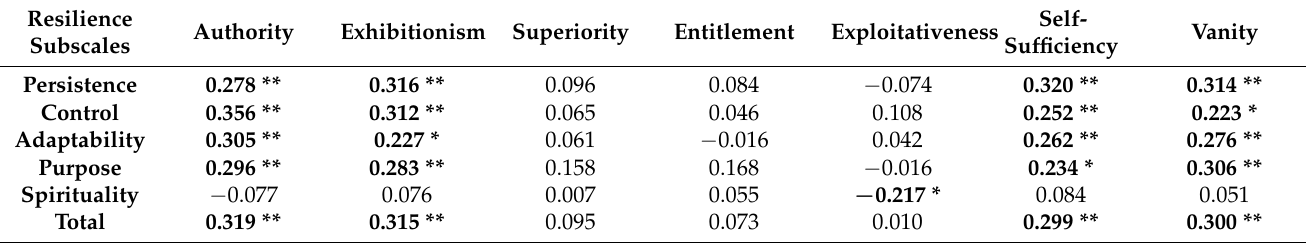
Table 2. Pearson correlations between narcissistic personality dimensions and